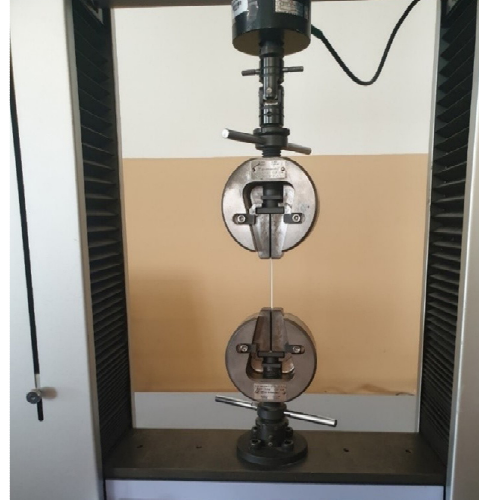
Figure 2. Representative macrograph of tensile test of the FOMM filaments. Five samples of each material and form were considered for the study. For all tested materials, the distance between opposite ends, span, was 50 mm, and the obtained results were analyzed on Trapezium X software (Tokyo, Japan). The results were displayed in stress–strain curves, from which the calculation of Young’s modulus (E) was performed, according to Equation (3) [43],